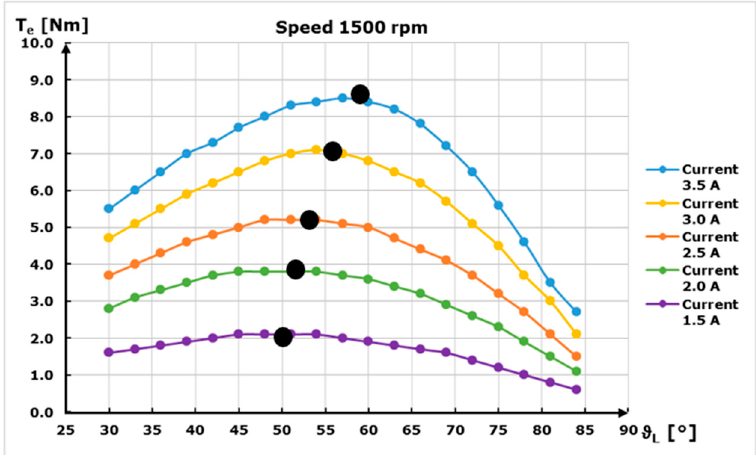
Figure 5. Torque versus load angle at 1500 rpm for various phase currents.